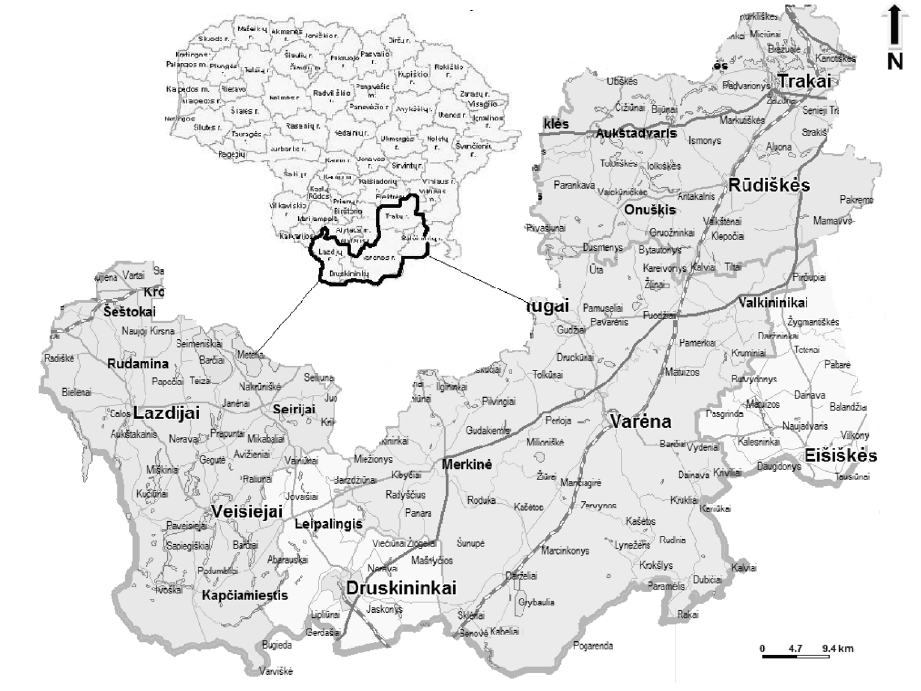
Fig. 1. Study site location in